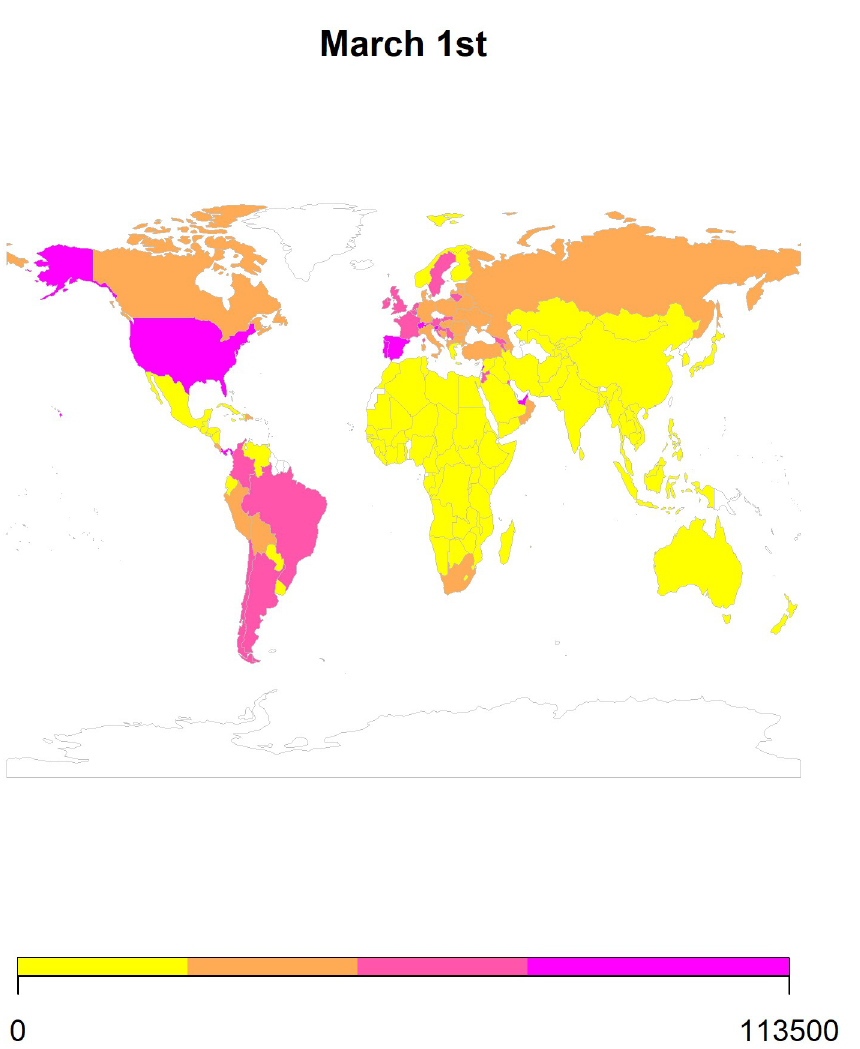
Fig 10. The heat map using the ARIMA forecasts for 1 st March